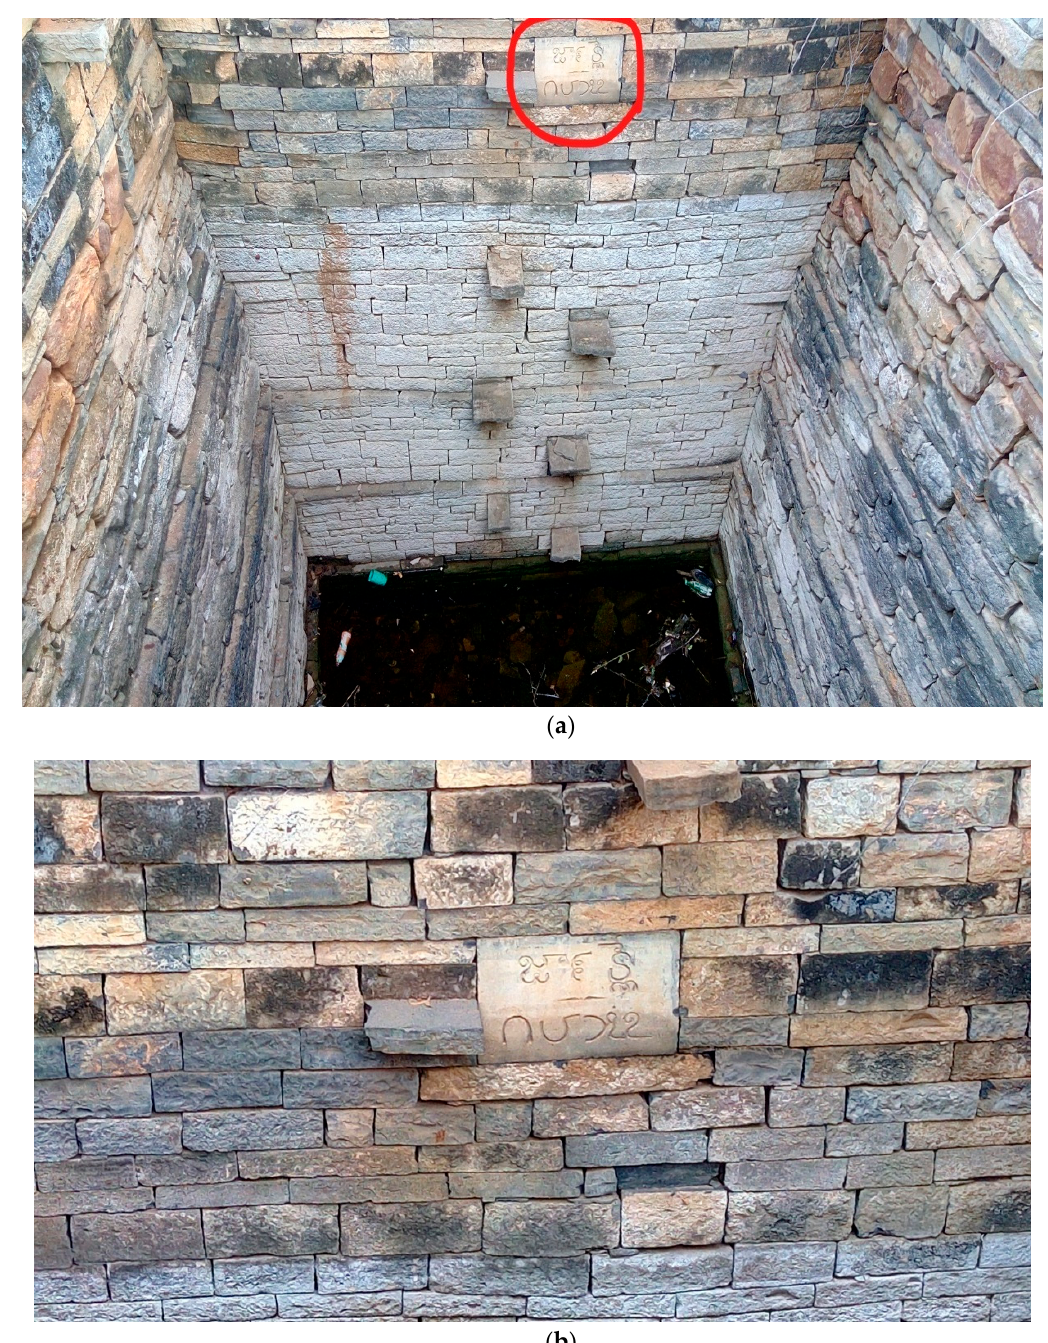
Figure 2. ( a ) Drinking water well dug by Missionary John Clay; ( b ) in the well, inscription of missionary name (John Clay) and year (1857) in Telugu language (Photo by the author). name (John Clay) and year (1857) in Telugu language (Photo by the